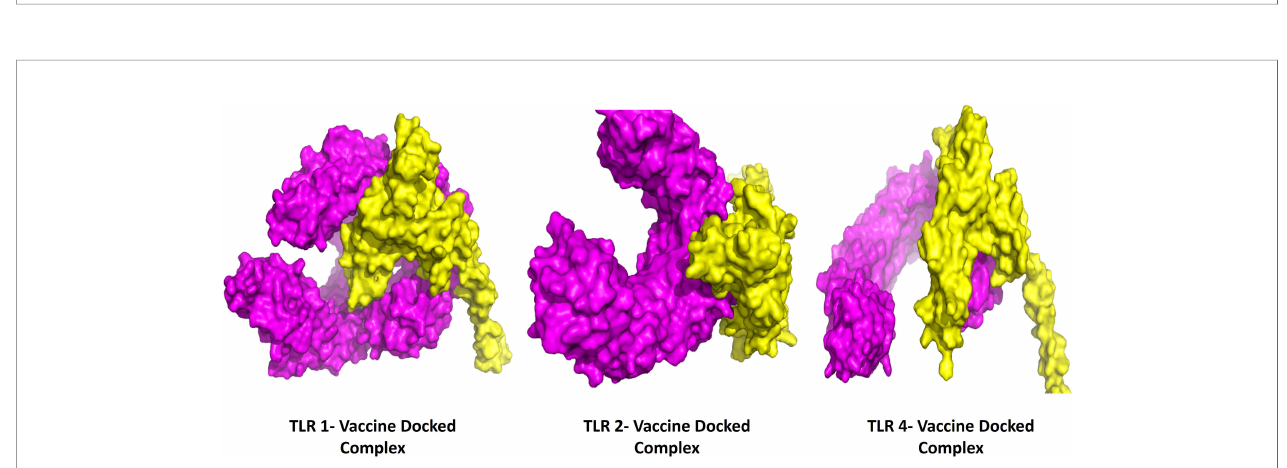
FIGURE 6 | The interactions of the BFV with several TLRs using the Discovery Studio